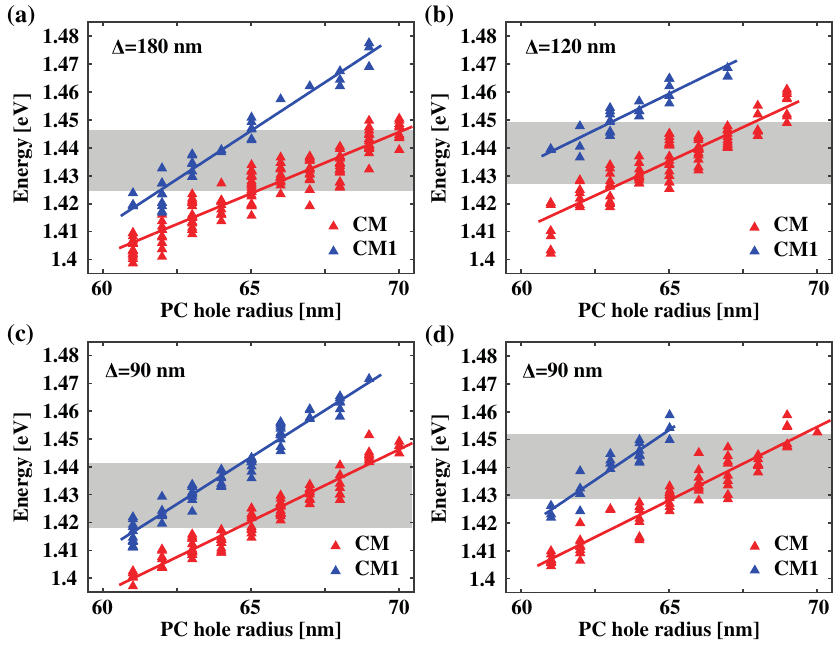
FIG. 11. Fundamental and the first excited CM energies with respect to the QD emission energy. (a) – (d) Energy positions of the two lowest energy TE modes (fundamental CM and the first excited CM 1 ) of L 3 PC cavities versus PC hole radius measured in 4 different square arrays with Δ ¼ 180 , 120, and 90 nm. The gray area denotes the QD ensemble emission energy measured in each square array prior to PC cavity